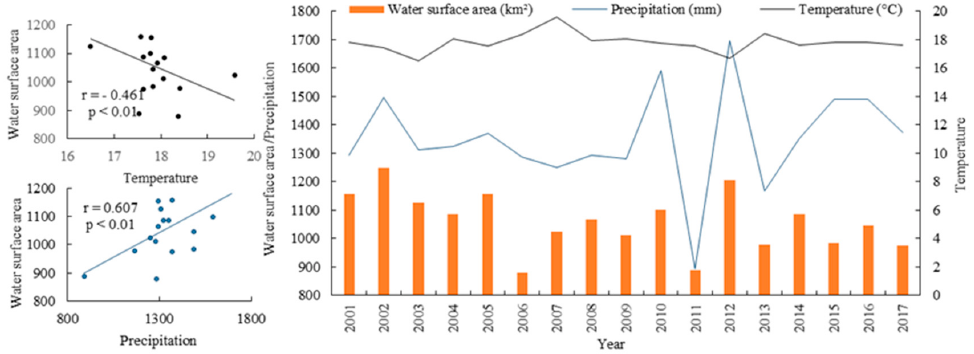
Figure 14. Relationships between the Dongting Lake water area and annual average temperature and annual average rainfall from annual average rainfall from 2001–2017.